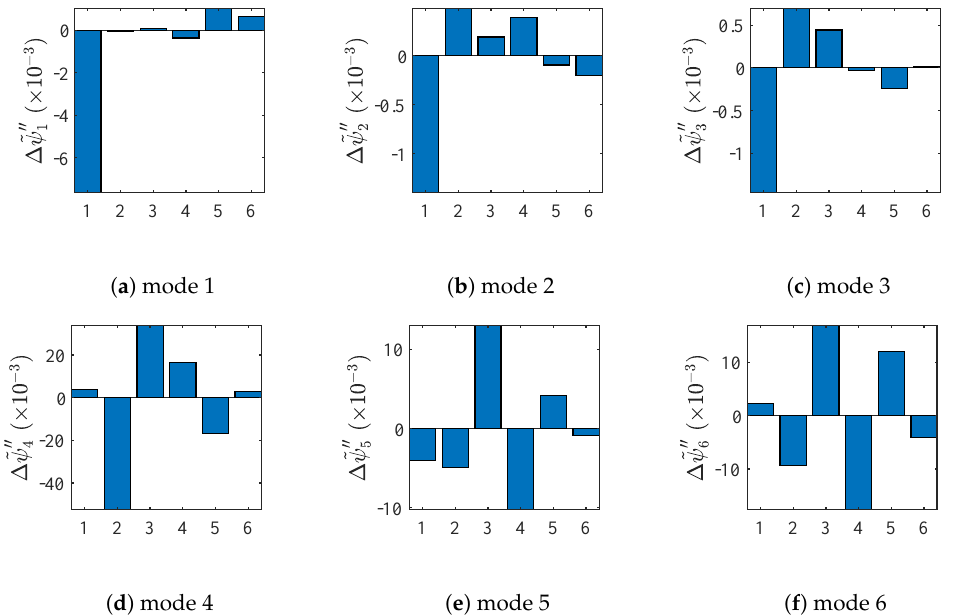
Figure 23. Shear frame: GP-ARX-based MSCs differences under 1% damage in K 1 , during a long time-scale instant from the validation